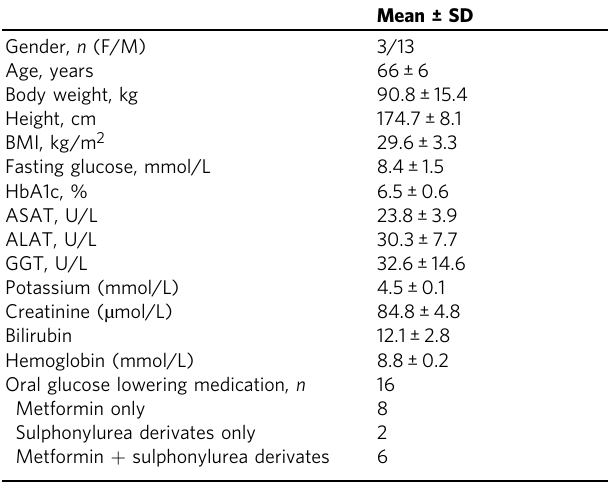
Table 1 Baseline characteristics a